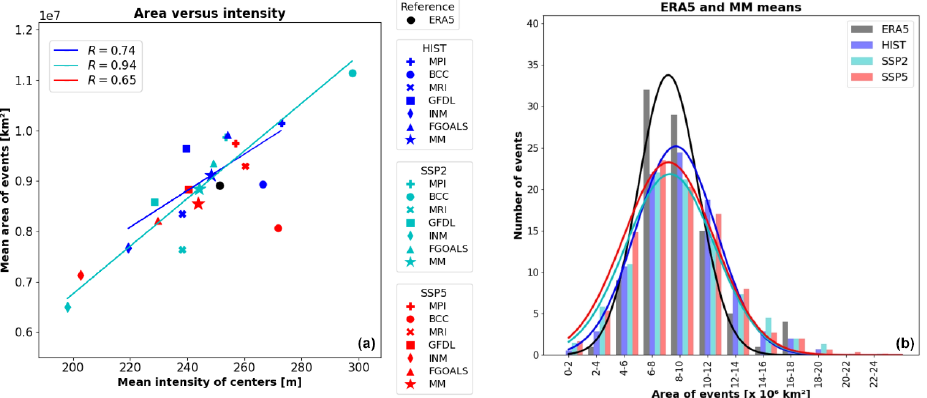
Figure 6. (a) Mean area versus mean centre intensity of blocking events computed for ERA5 and the GCMs during HIST, SSP2, and SSP5. (b) Occurrence of blocking events as a function of blocking area for ERA5 and the GCMs during HIST, SSP2, and SSP5. Gaussian fits are drawn for ERA5 and MM means. Both plots show the results for (cid:49) Z500 HIST , (cid:49) Z500 SSP2 , and (cid:49) Z500 SSP5